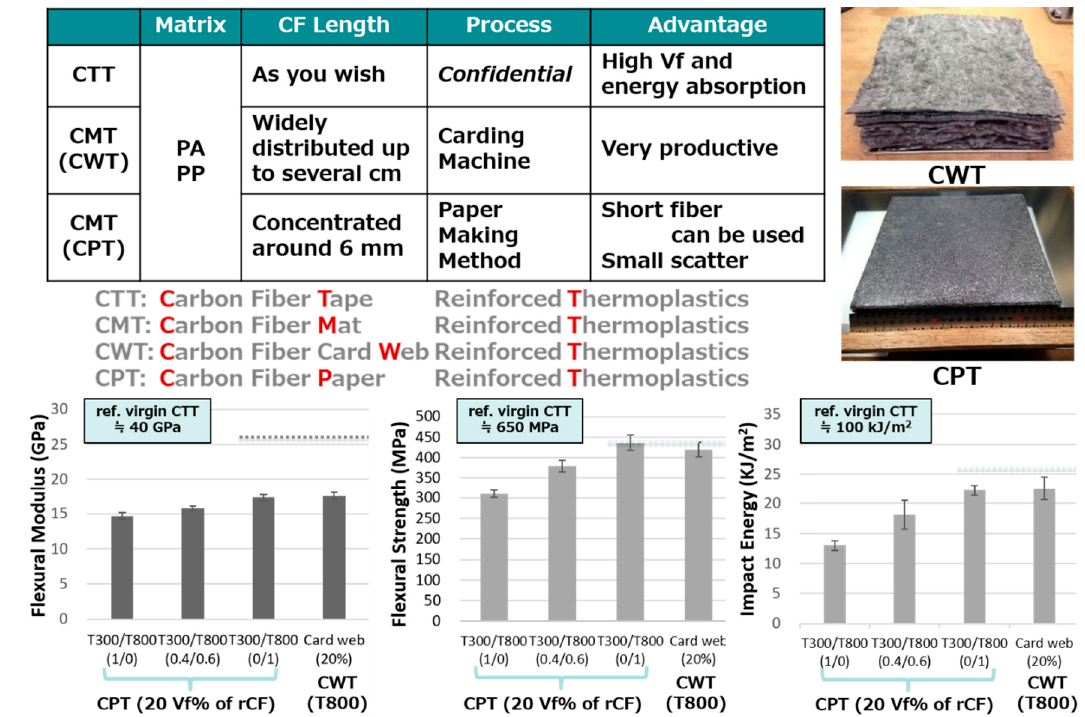
Figure 13. Fabrication and mechanical properties of CTTs, CWTs, and CPTs.